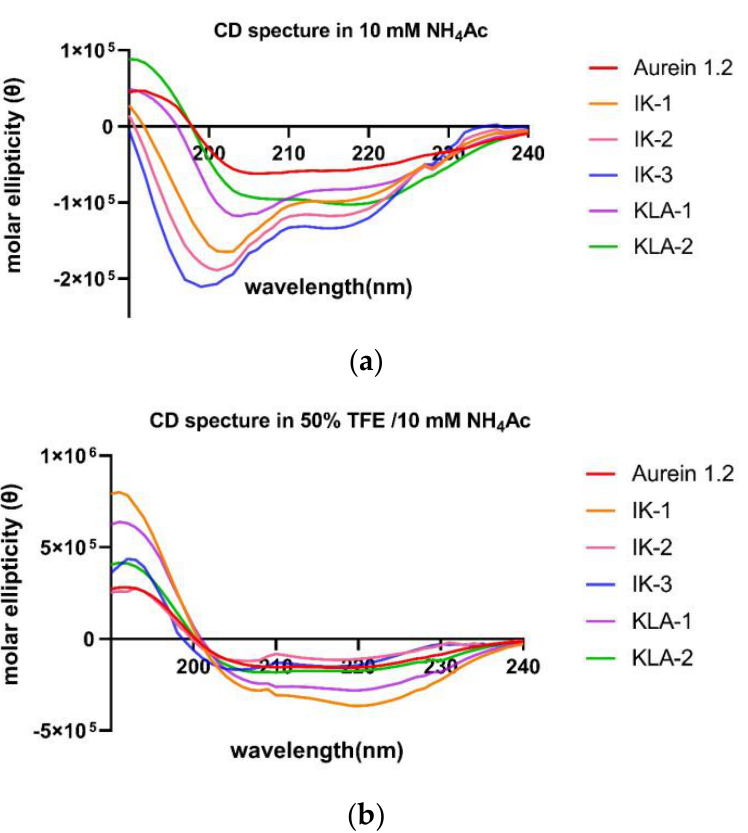
Figure 3. CD spectra of aurein 1.2 (red); IK-1 (orange); IK-2 (pink); IK-3 (blue); KLA-1 (purple) and KLA-2 (green) in ( a ) 10 mM NH 4 Ac solution and ( b ) 50% TFE/10 mM NH 4 Ac solution.